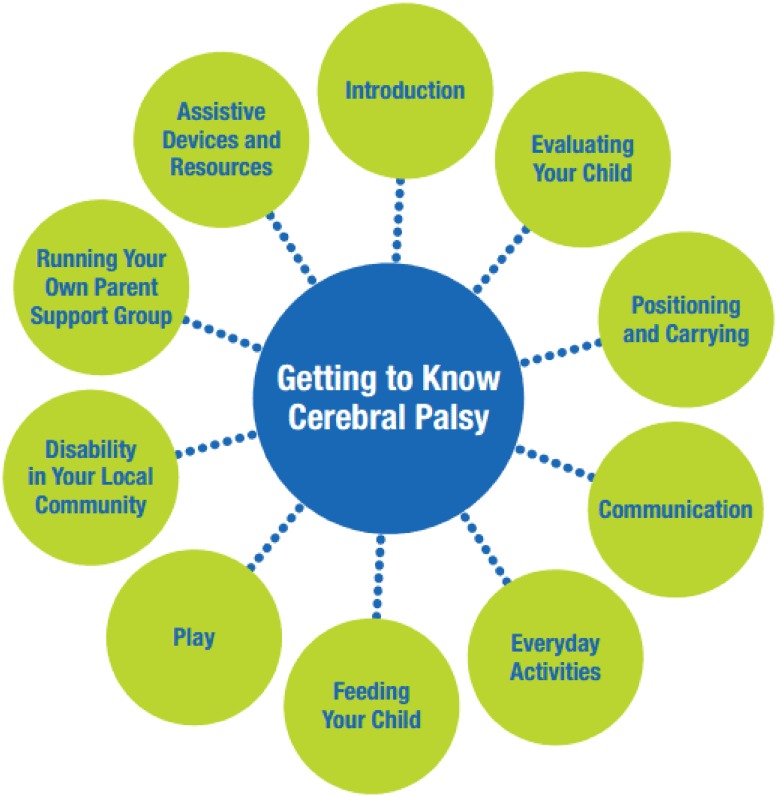
Modules of training programme.